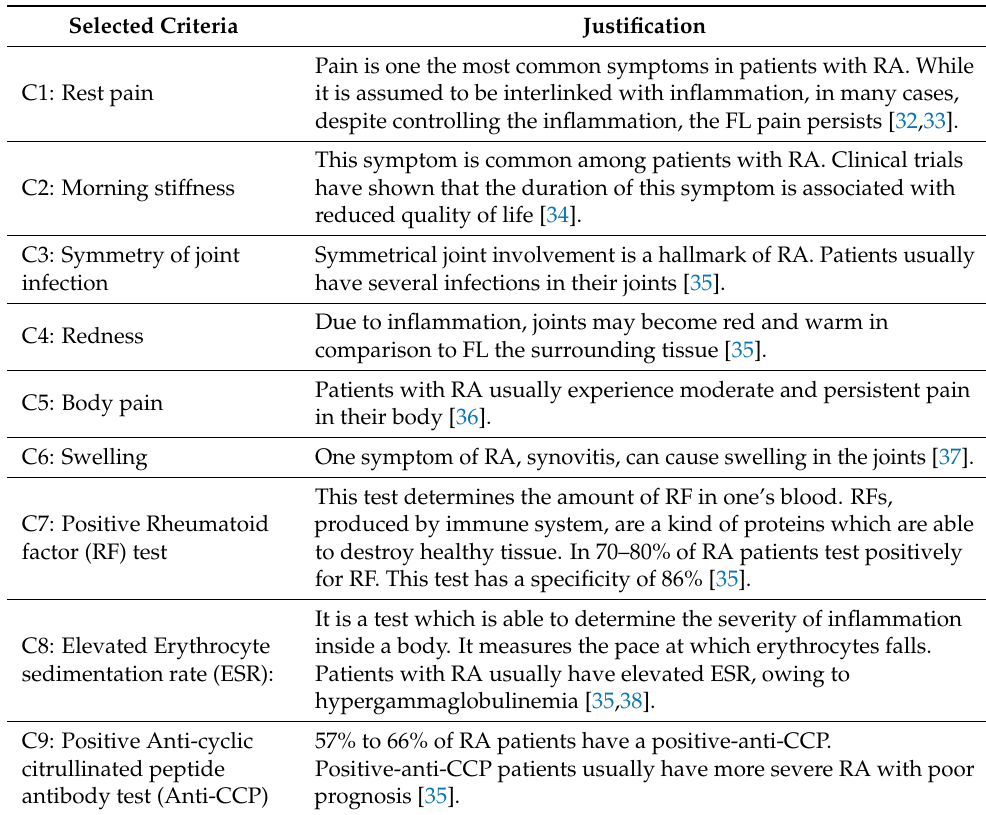
Table 1. Criteria for diagnosis of patients with RA and their explanations. Selected Criteria